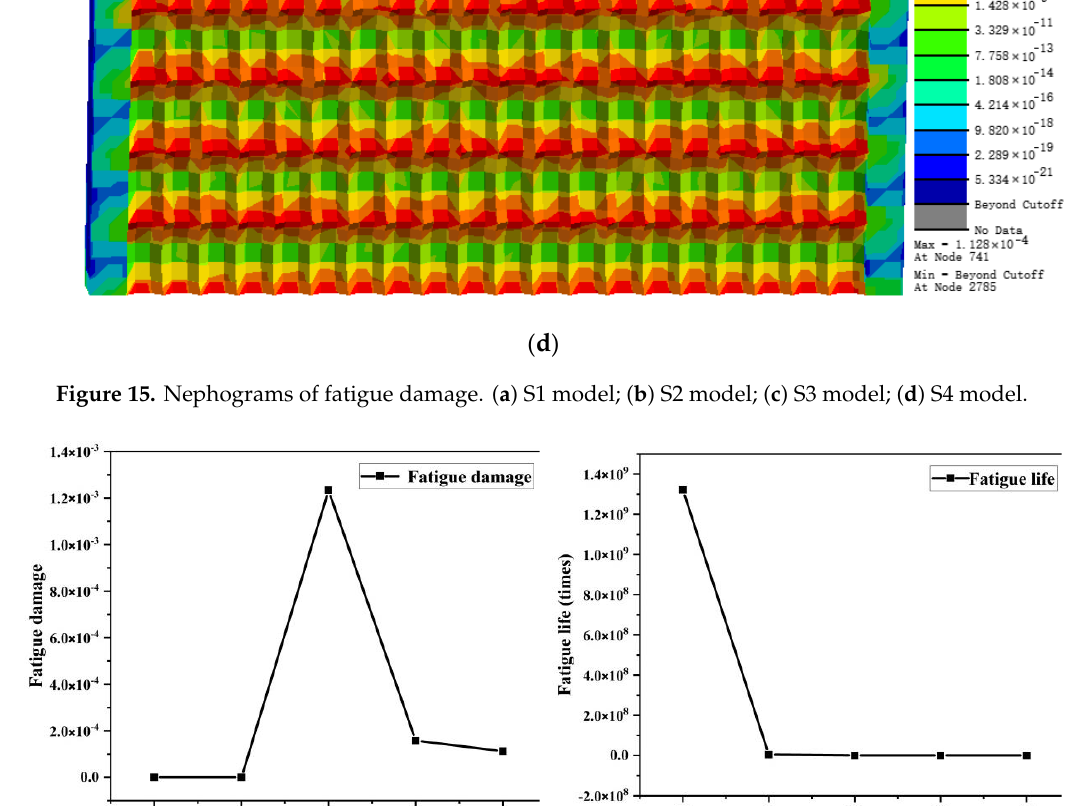
Figure 15. Nephograms of fatigue damage. ( a ) S1 model; ( b ) S2 model; ( c ) S3 model; ( d ) S4 model.